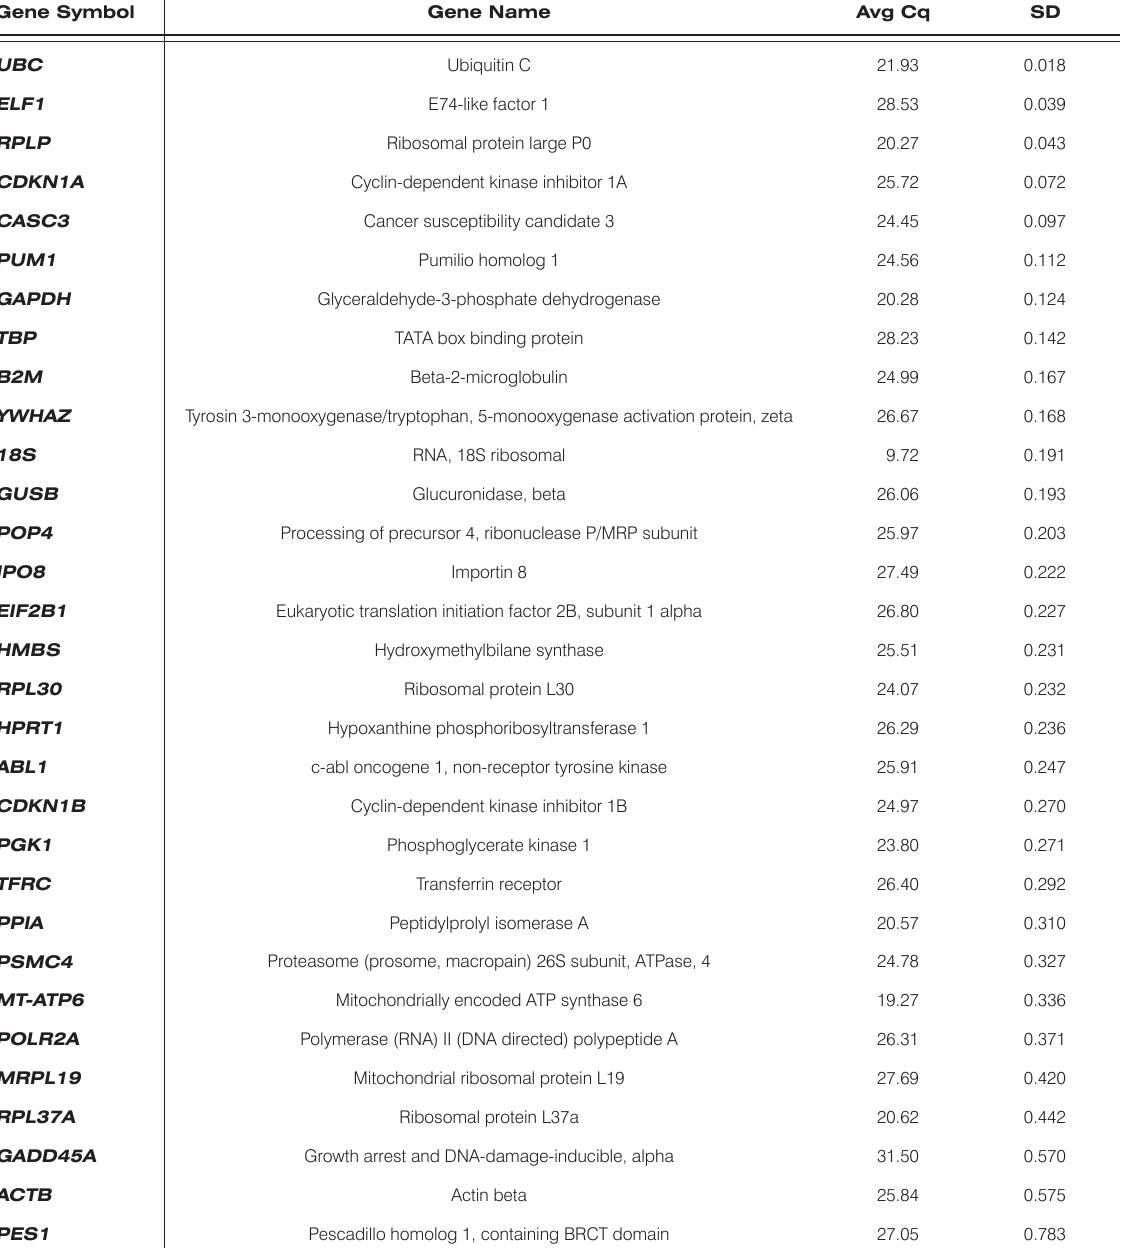
Table 4. TaqMan Endogenous Control Express Plate analysis of SH-SY5Y